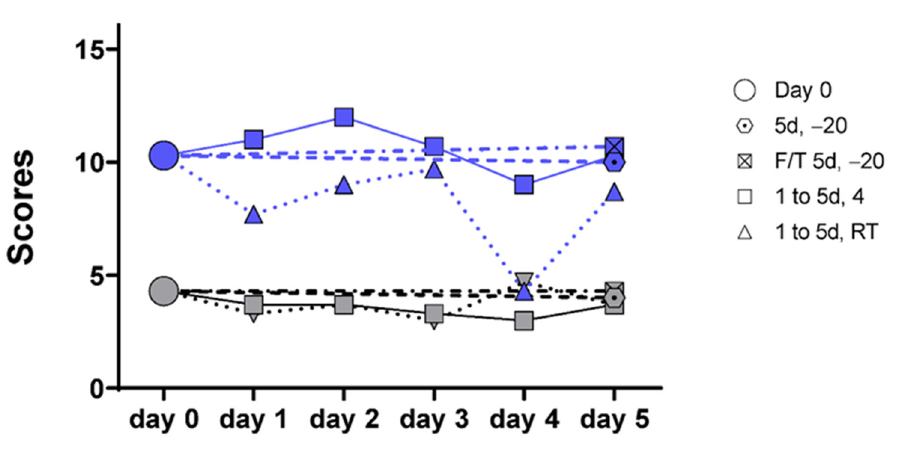
Figure 5. Target stability analyses in stool samples over a 5-day period. Target stability was tested under various conditions of conservation and target detection was monitored throughout the 5 days in samples maintained at − 20 °C with (F/T 5d, − 20) and without (5d − 20) a thaw cycle, at 4 °C (1 to 5d, 4) and at room temperature (1 to 5d, RT). Data for individual targets in copy number are provided in Figure S1. Cumulative scores including the 4 tested targets PTGS2, CEACAM5, ITGA2 and ITGA6 showed that overall, the targets were relatively stable for the five days under all cooled conditions and for three days at room temperature for both controls (Gray symbols) and CRC (Blue